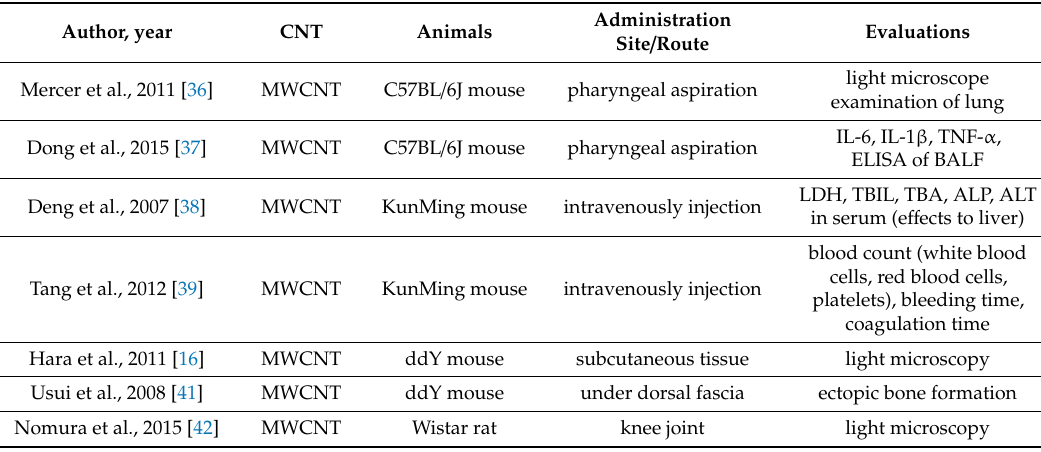
Table 2. In vivo biocompatibility testing of